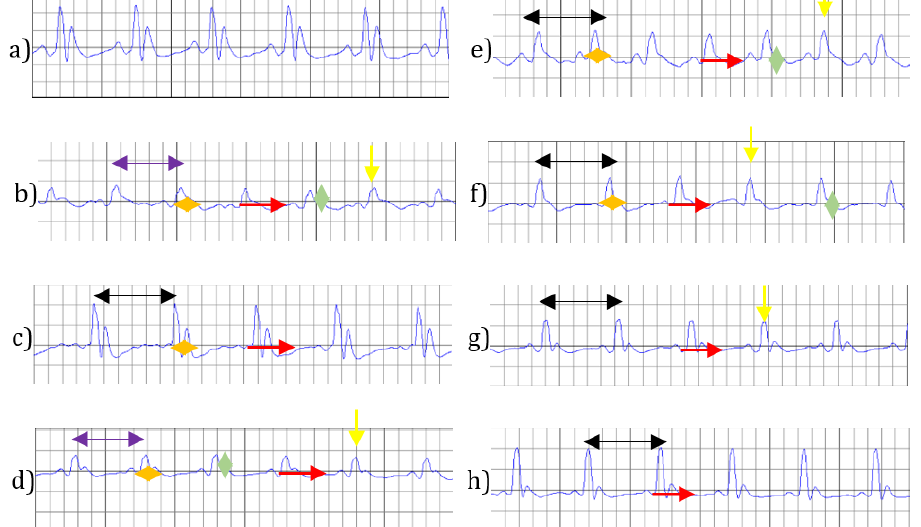
Figure 3. ECG changes characteristic of each group. ( a ) C, ( b ) AMI, ( c ) T1DM, ( d ) T1DM-AMI, ( e ) S-T1DM-CC-AMI, ( f ) CC-T1DM-CC-AMI, ( g ) S-T1DM-NC-AMI, ( h ) NC-T1DM-NC-AMI. Increased RR interval (black arrow), reduced RR interval (purple arrow), lengthening of the QRS complex (orange arrow), increased QT interval (red arrow), ST-segment elevation (green arrow), reduced amplitude of the R wave (yellow arrow). C—control; AMI—acute myocardial infarction; T1DM—type 1 diabetes mellitus; S—saline (0.09%); CC—conventional curcumin solution (200 mg/Kg bw); NC—solution of curcumin nanoparticles (200 mg/Kg bw). Table 1. ECG interpretation for each group.